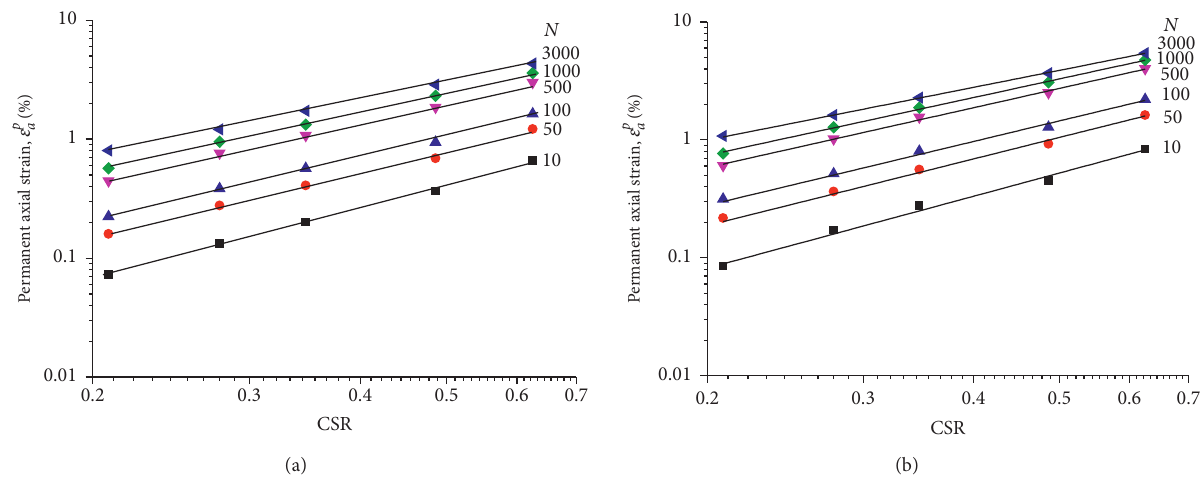
Figure 8: Relationships between permanent axial strains at selected cycle numbers and CSR: (a) η ampl � 1; (b) η ampl � 0.5.